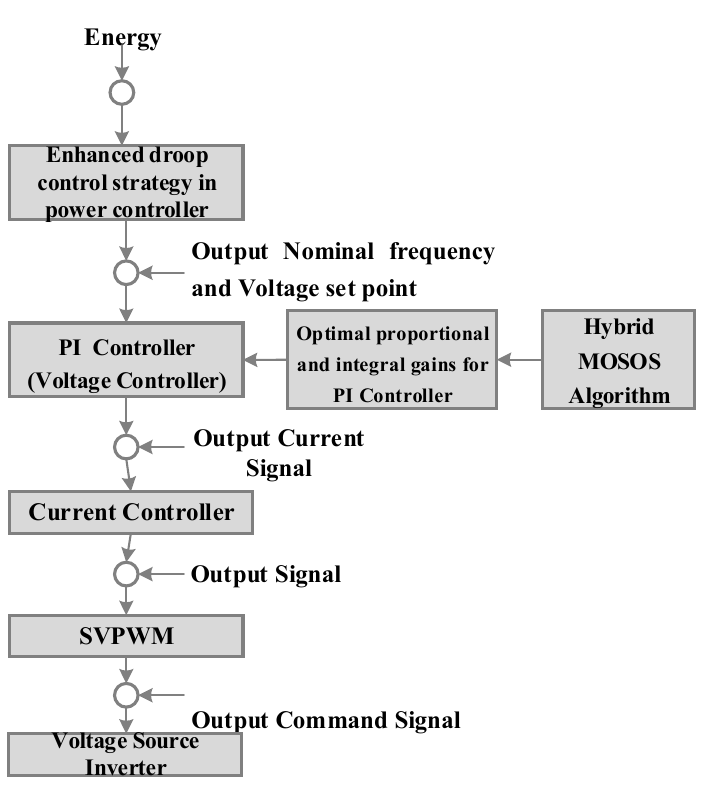
Figure 2. Flow diagram of control scheme for voltage source controller.